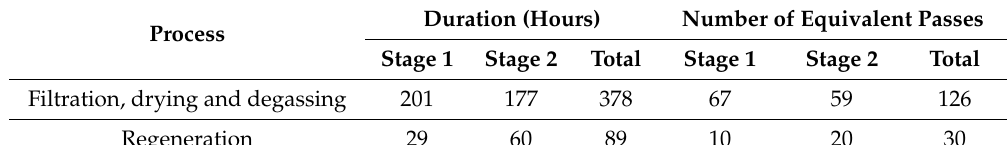
Table 3. Operating time of the oil regeneration experiment.